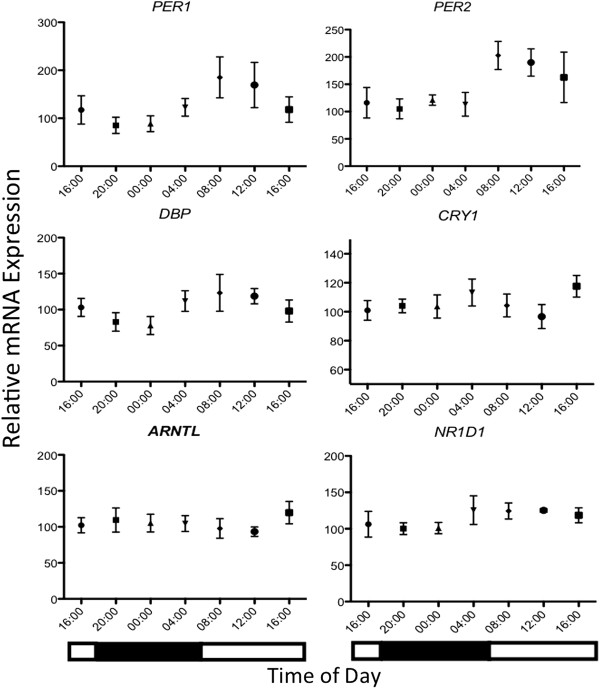
24-h profiles of mRNA expression. Plotted are mRNA levels of the candidate genes relative to reference genes ACTB and HPRT1 in equine hair follicles. Data are presented as means ± SEM. Black and white bars indicate hours of darkness and light, respectively. ANOVA revealed significant 24-h variation for PER1, PER2 and DBP (p = .024, p = .02 and p = .03;, respectively) whereas Cosinor analysis confirmed a significant 24-h component for PER1, DBP and NR1D2 (p = .002, p = .0331 and p=.03;, respectively.